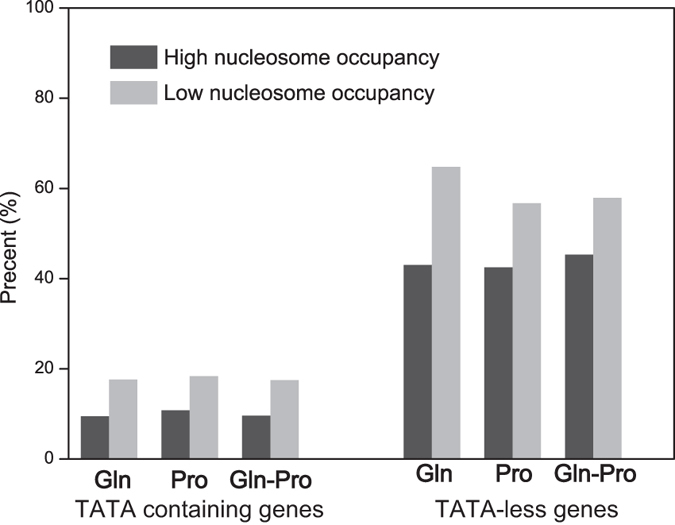
Percentage of TATA-containing and TATA-less genes with high or low nucleosome occupancy.Distribution of TATA-containing and TATA-less genes with high or low nucleosome occupancy. Gln, Pro and Gln-Pro represent the culture conditions in M.Gln, M.Pro and in response to the shift from M.Gln to M.Pro for 2 h, respectively.